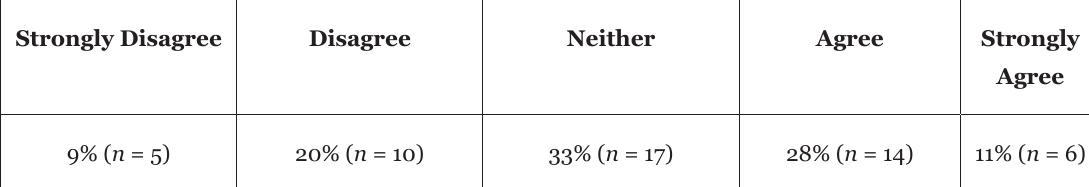
Given the lack of concern while transitioning there also appeared to be an understanding of why Nipissing University moved to a new version of Blackboard (Learn).